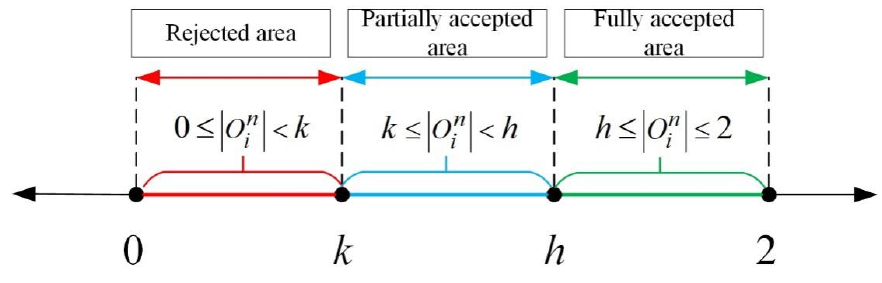
Figure 3. Individuals’ acceptance of external information.